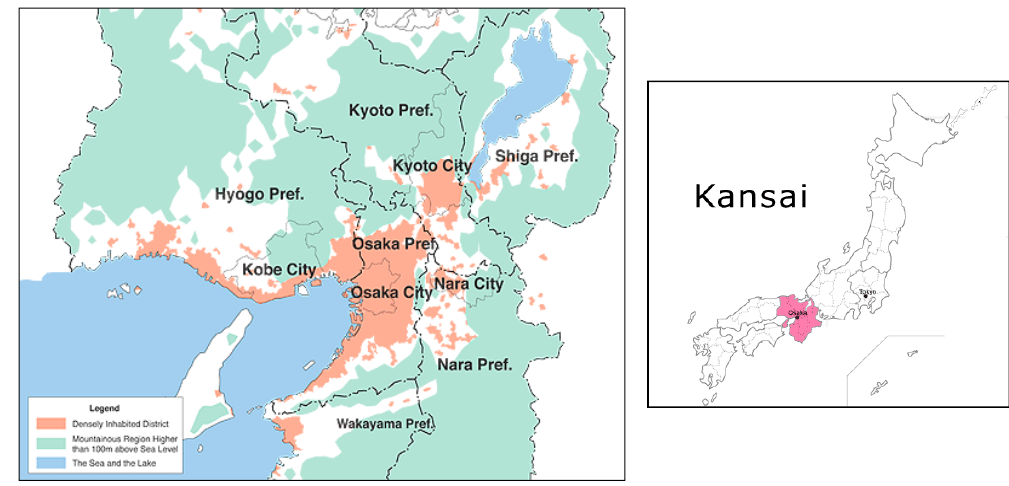
Figure 1. Study area is the Kei-Han-Shin area, which includes the Prefectures (Pref.) of Kyoto, Osaka, and Kobe.